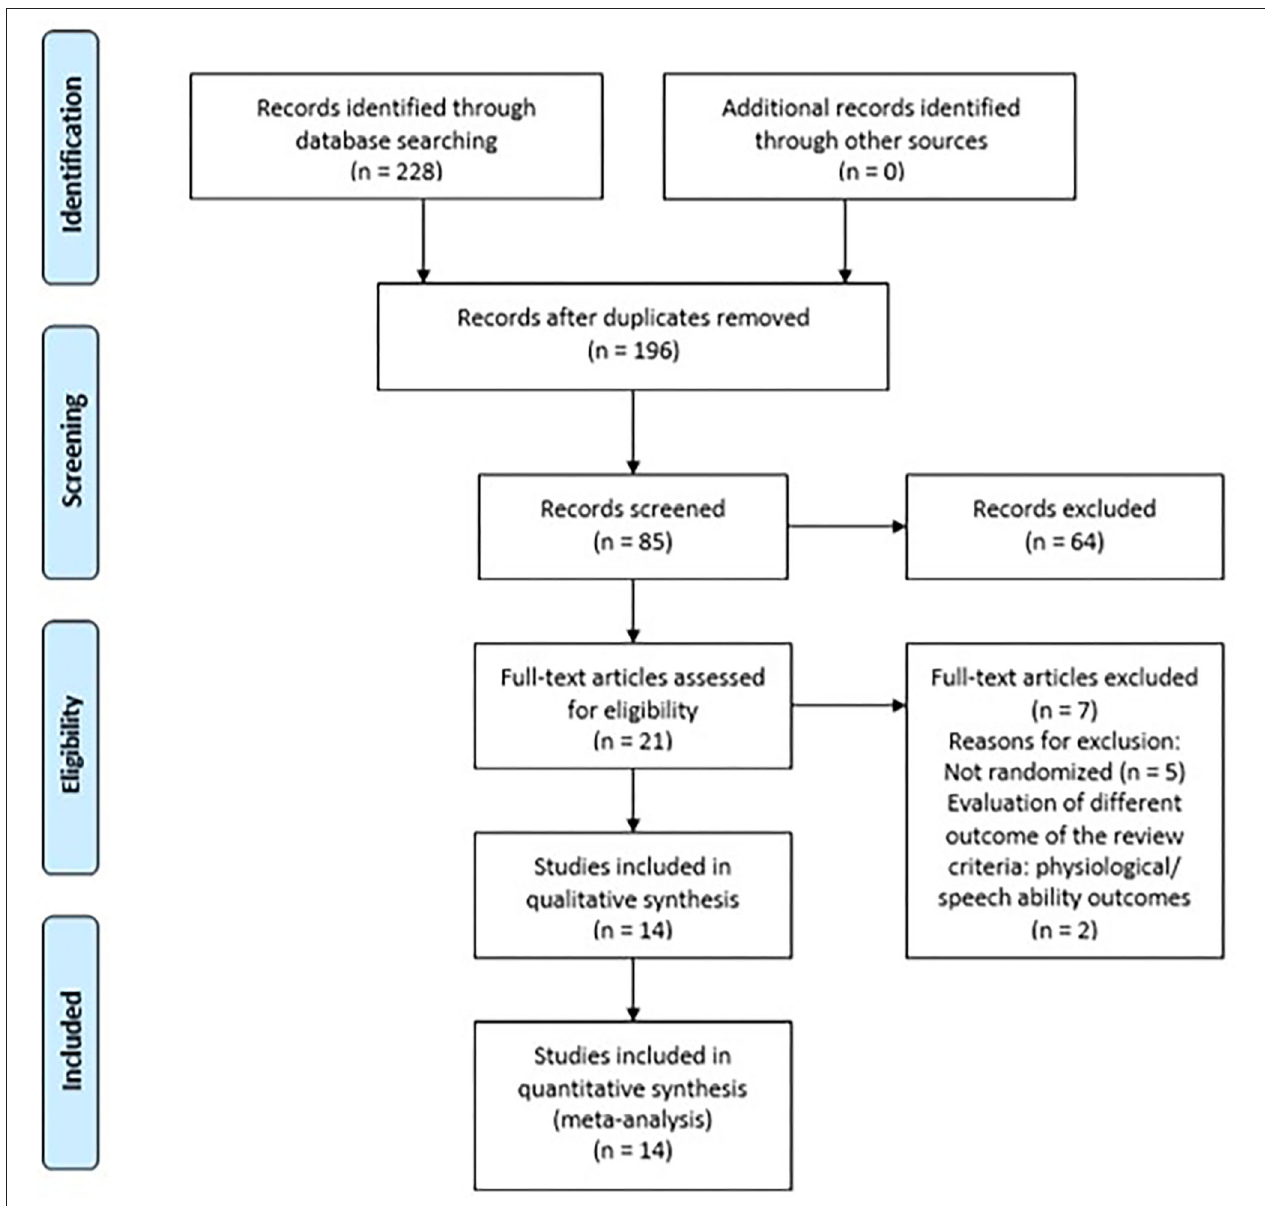
FIGURE 1 | Preferred Reporting Items for Systematic reviews and Meta-Analyses (PRISMA) flowchart for the selection of the included studies.